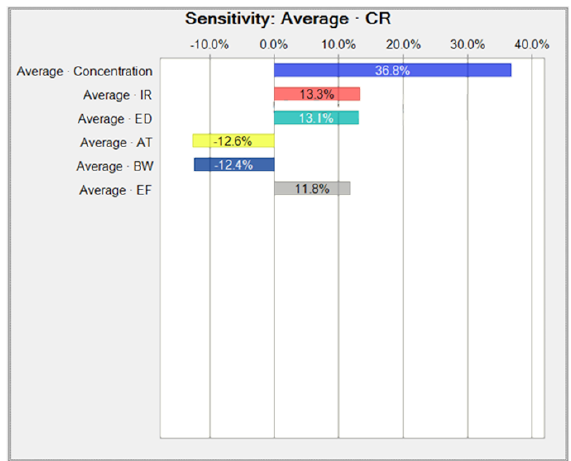
Figure A2. SA of LTCR model (adults) for Ni in water.